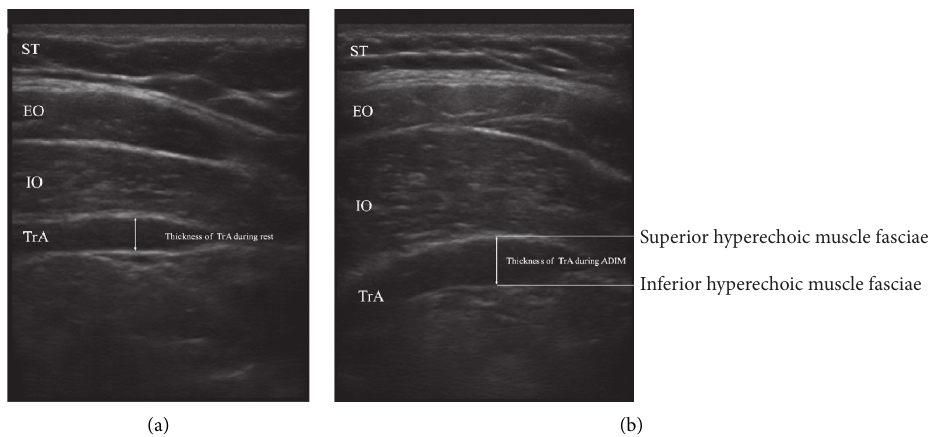
Figure 1: Ultrasound images and measures of transversus abdominis muscles. (a) Relaxed state. (b) Contracted state. EO: external oblique; IO: internal oblique; TrA: transversus abdominis; ST: subcutaneous tissue; and ADIM: abdominal drawing-in